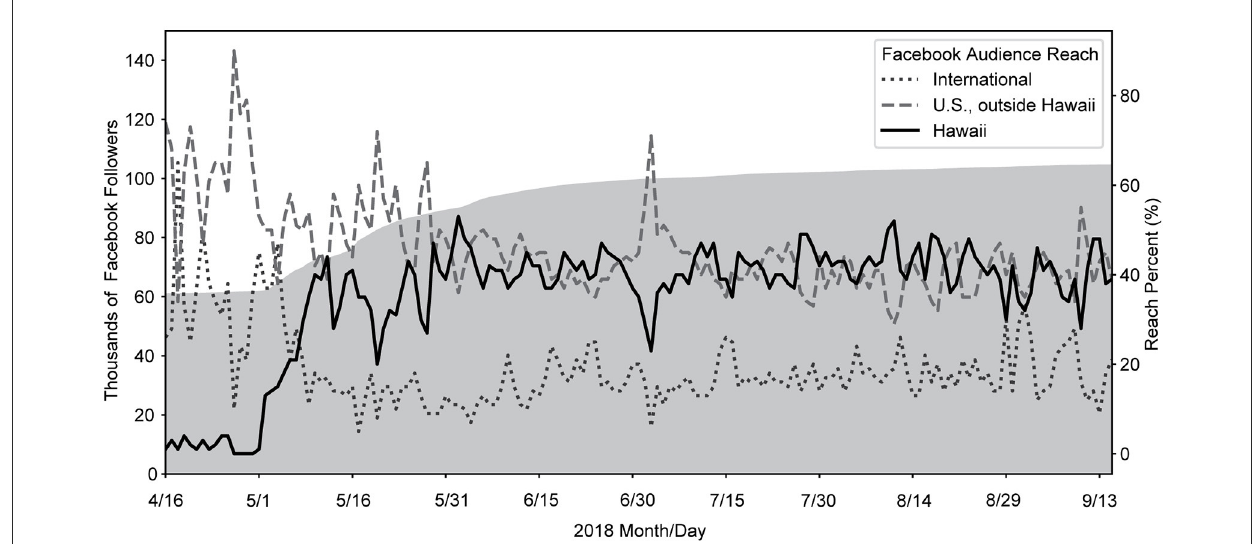
FIGURE4 USGS Volcanoes’ Facebook data from April 16 to September 15, 2018. Cumulative followers (shaded gray area, left axis) grew quickly during the 1st month of the eruption as a greater percentage of people from the State of Hawaii (solid black line, right axis) viewed